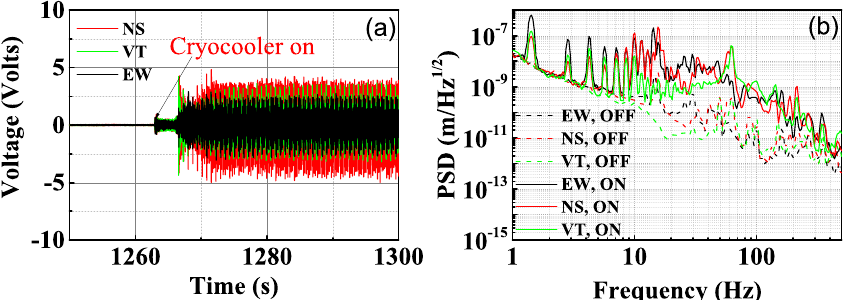
Figure 1. ( a ) Voltage outputs of the geophone sensors when the cryocooler has just been turned on. Vibrations on three independent directions are measured. The red curve for north–south direction (NS), the black curve for east–west direction (EW), and the green curve stands for vertical direction (VT). ( b ) Power spectral density of the vibrational noise on the cryogenic plate. The dashed lines are for measurements when the cryocooler is off and the solid lines are for measurements taken when the cryocooler is on.